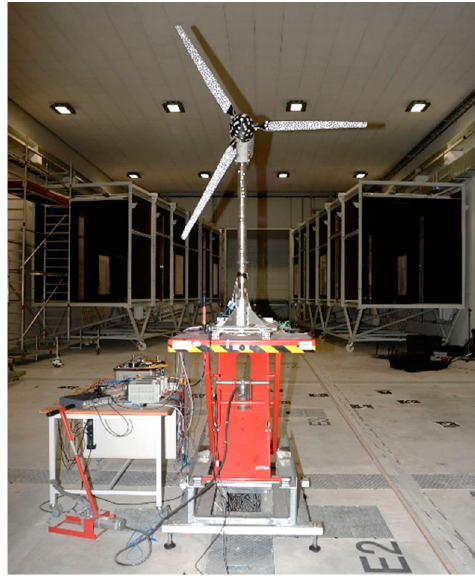
Figure 2. Model Wind Turbine Oldenburg (MoWiTO).